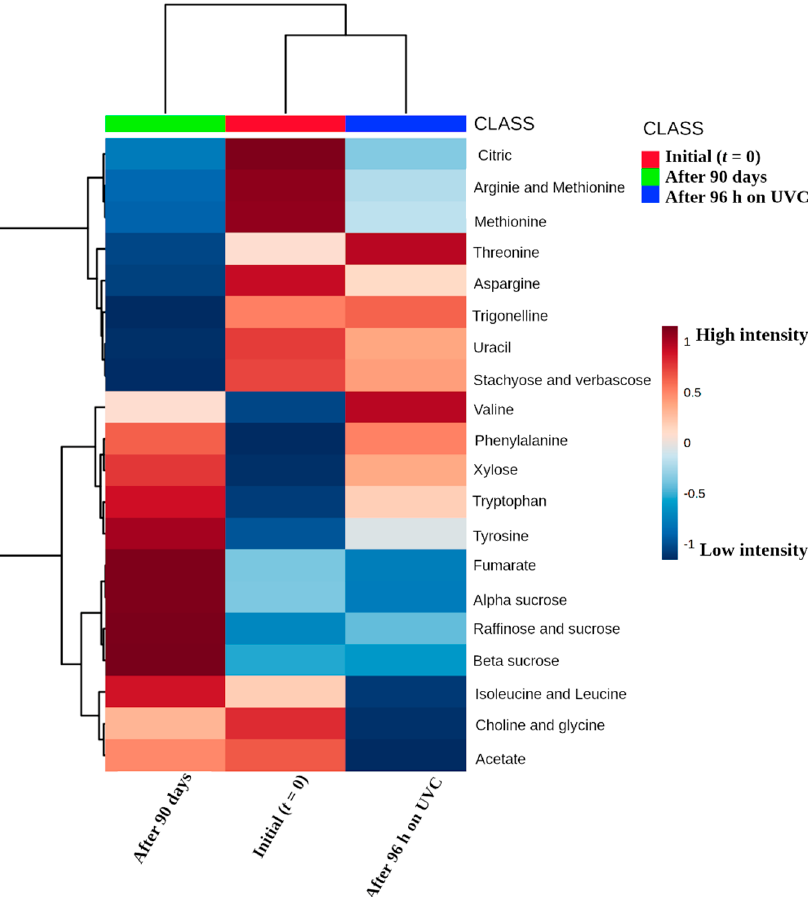
Figure 5. Visualization to the heatmap plot representing chemical composition similarity relationships with the different conditions of the darkening. The dark red color represents the maximum intensity, while the dark blue color represents the lowest intensity, respectively.